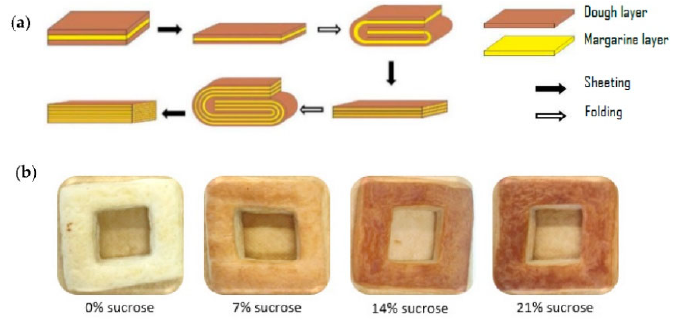
Figure 1. ( a ) Sheeting and folding process in the production of layered pastry dough [29]. Margarine layers (yellow) are folded into the predough (brown), resulting in one margarine layer and two dough layers. The dough is then repeatedly sheeted and folded until 27 fat layers are obtained. Reproduced with permission. ( b ) Baked end-product with 27 fat layers and 0, 7, 14 or 21% sucrose, made with a squared